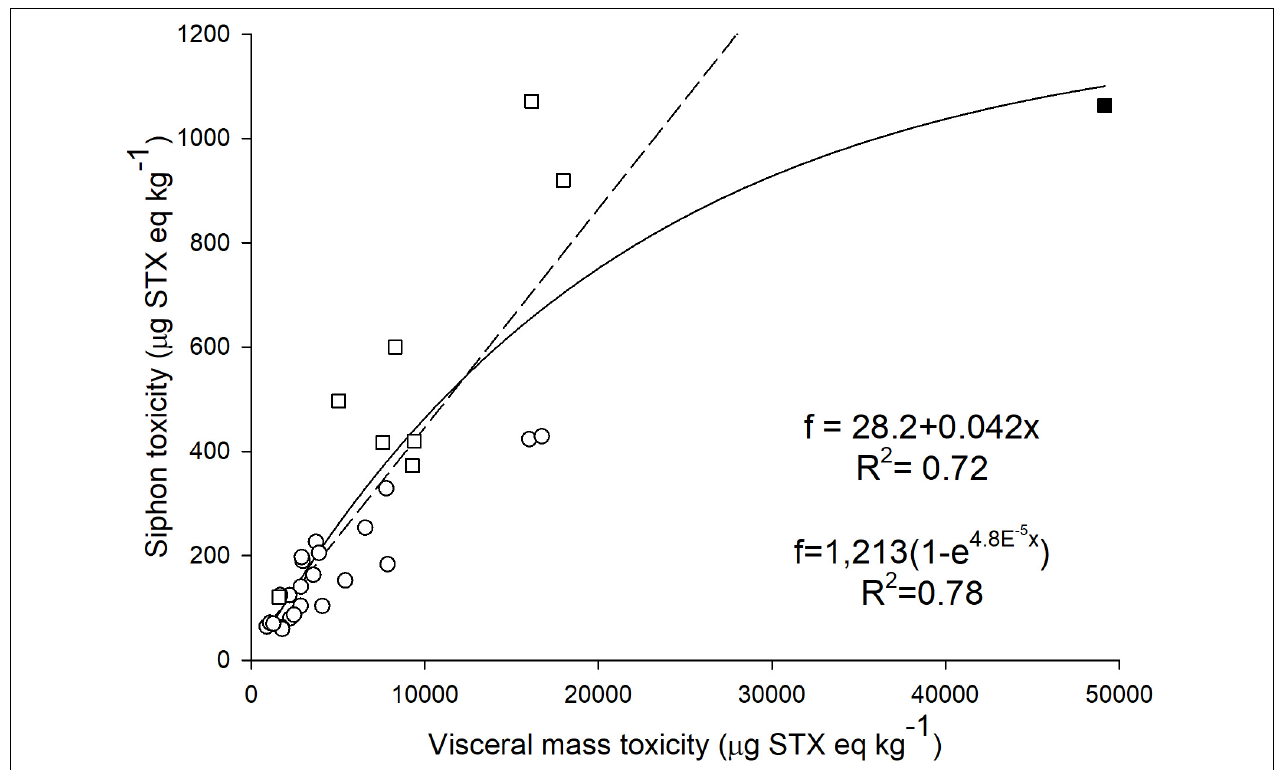
FIGURE 4 | Relation between calculated toxicity of the siphon and visceral mass in geoduck samples collected during 2015 (circles) and 2017 (squares). The filled square shows the highest paralytic shellfish toxin concentration detected in viscera in 2017. This point was omitted (outlier) when a linear regression analysis was applied ( R 2 = 0.72, dashed line; see text). An exponential rise to a maximal function was used for the regression analysis considering all data ( R 2 = 0.78, solid line).